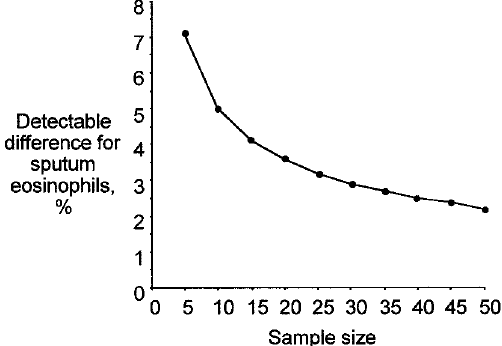
FIG. 2. Plot of detectable differences versus sample size required, based on 80% power and p = 0.05, for sputum eosinophil